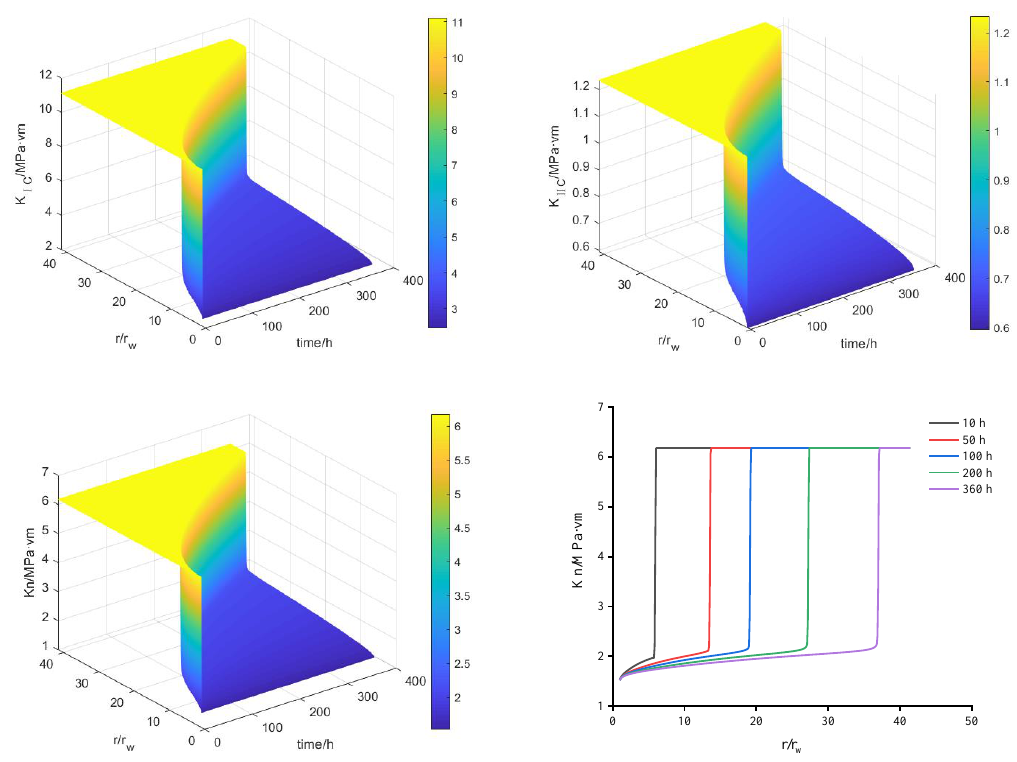
Figure 6. Variation of fracture toughness with dimensionless distance and time ((left) type I fracture toughness and (right) type II fracture toughness).